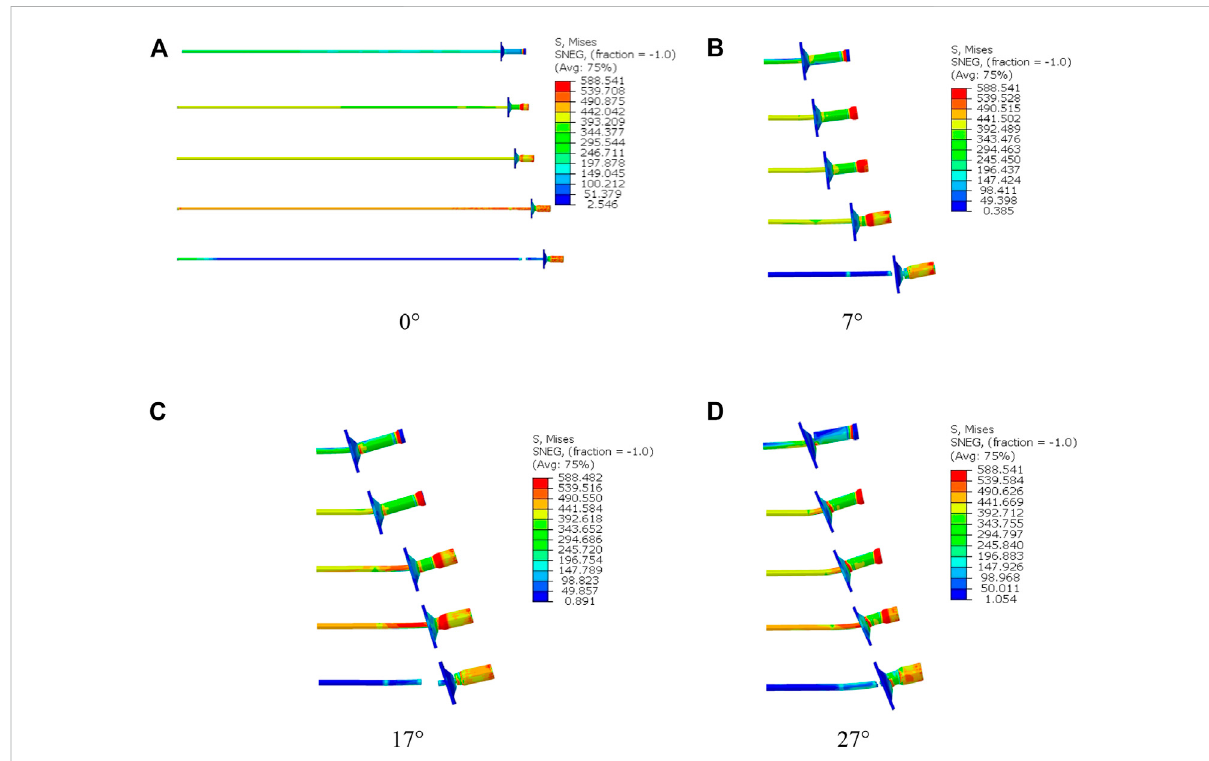
FIGURE 4 Deformation of bolt and anti-punching device at partial de fl ection angles.